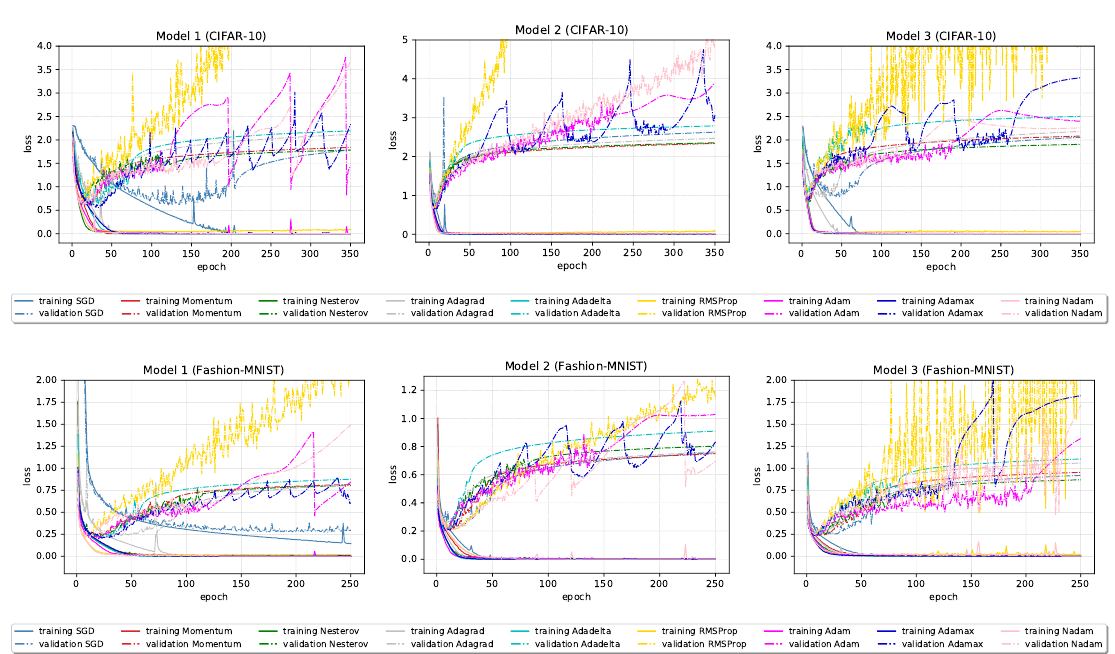
Figure 3. Loss learning curves for all optimizers on baseline